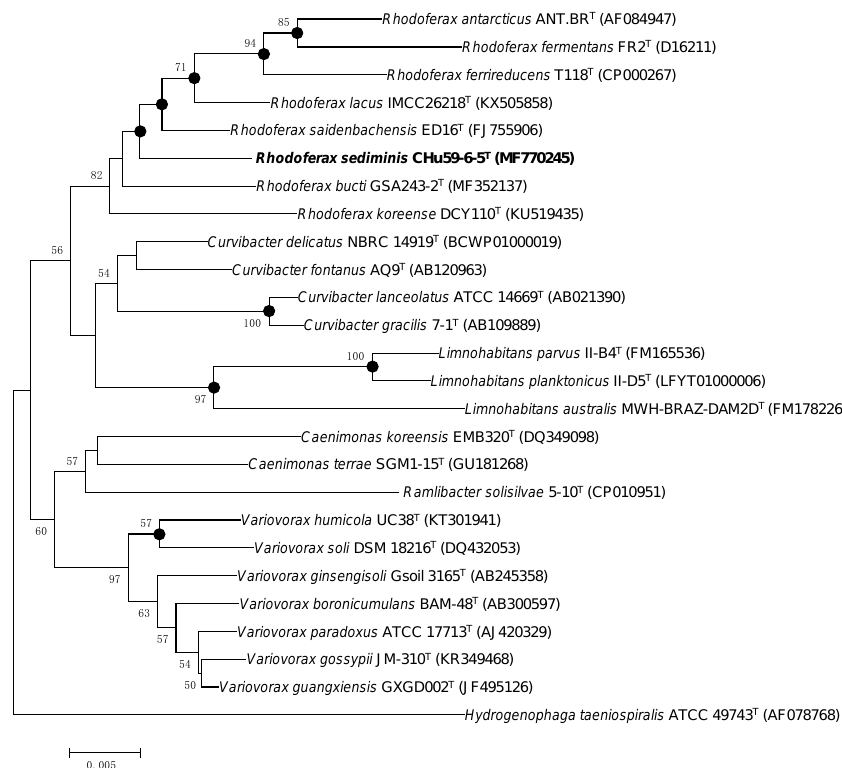
Figure 2. Phylogenetic tree constructed using the neighbor-joining method in MEGA 7 which depicts the phylogenetic relationship of strain CHu59-6-5 T among related taxa. The tree was reconstructed based on 1399 nucleotides. Numbers at branching points refer to bootstrap values (1000 resamplings, values above 50% shown). Bar, 0.5 substitution per 100 nt positions. Filled circles indicate that the corresponding nodes were also calculated in trees generated with the algorithms of maximum-likelihood and maximum-parsimony.